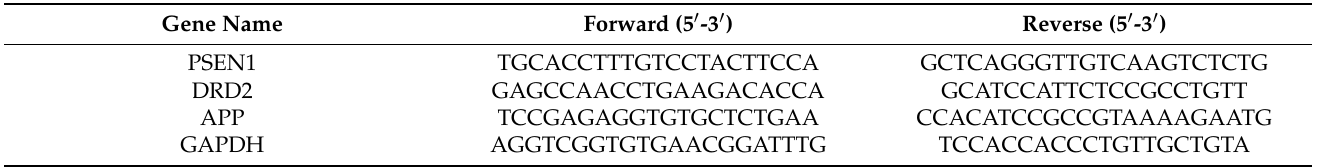
Table 4. Primer sequences used for qPCR